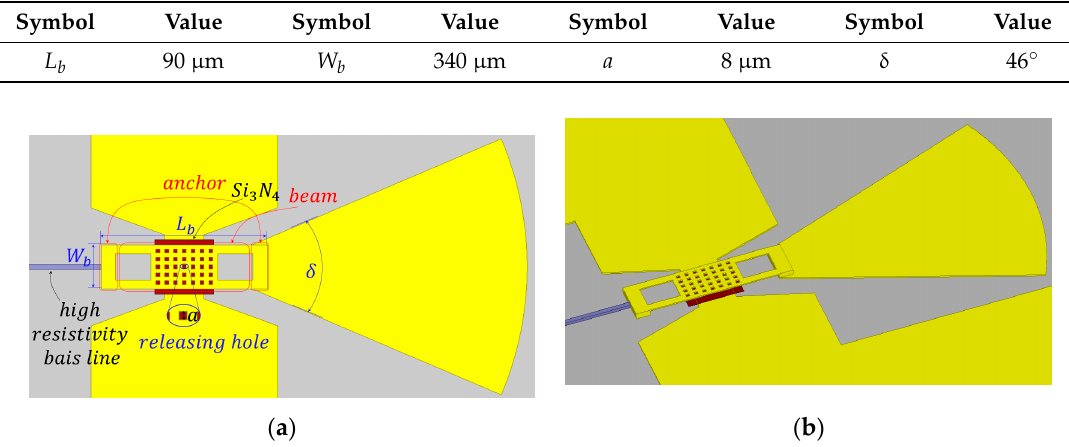
Table 3. The pivotal size of the designed RF MEMS switch.